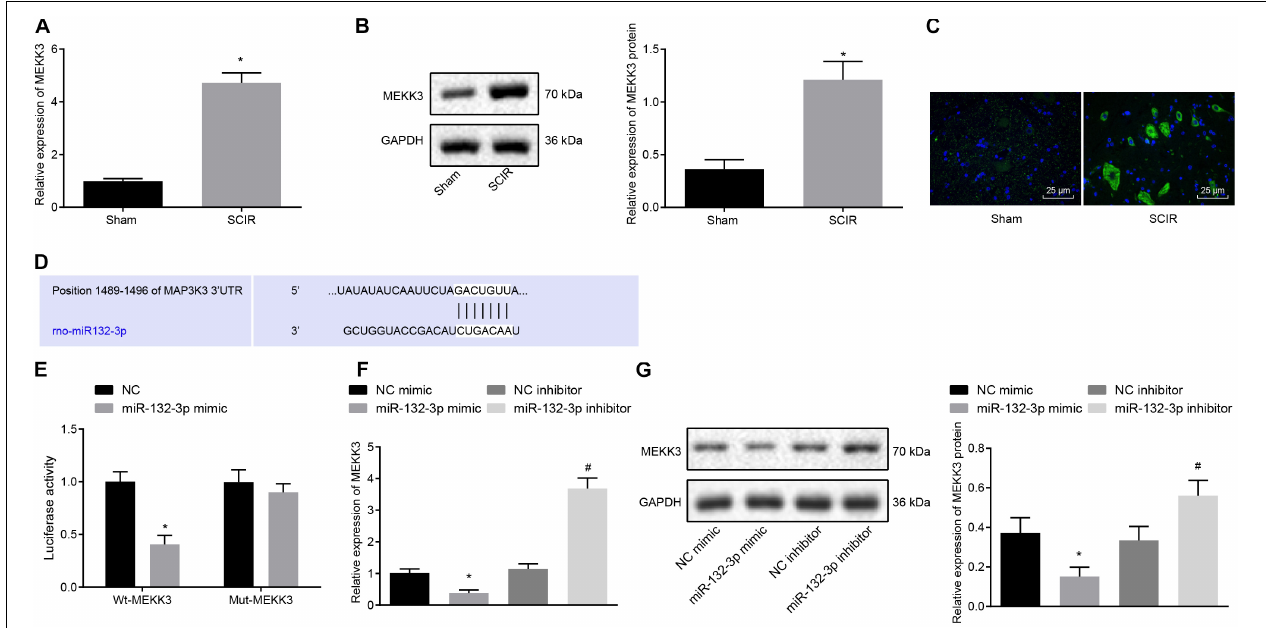
FIGURE 3 | Spinal cord tissues of SCIR injury rats present with high expression of MEKK3 which is a target gene of miR-132-3p. (A) mRNA expression of MEKK3 in spinal cord tissues of sham-operated rats and SCIR injury rats measured by RT-qPCR. (B) Protein expression of MEKK3 in spinal cord tissues of sham-operated rats and SCIR injury rats measured by Western blot analysis; n = 8. (C) Expression of MEKK3 and CD68 in spinal cord tissues of sham-operated rats and SCIR injury rats detected by immunofluorescence staining. (D) Binding sites of miR-132-3p to the 3 (cid:48) UTR of MEKK3 mRNA predicated by a bioinformatics database. (E) Luciferase activity of cells co-transfected with miR-132-3p mimic and MEKK3-WT or MEKK3-MUT detected by dual-luciferase reporter gene assay. (F) mRNA expression of MEKK3 in cells treated with miR-132-3p mimic, miR-132-3p inhibitor, or their NC plasmids detected by RT-qPCR. (G) Protein expression of MEKK3 in cells treated with miR-132-3p mimic, miR-132-3p inhibitor, or their NC plasmids measured by Western blot analysis. ∗ p < 0.05 vs. macrophages transfected with NC mimic. # p < 0.05 vs. macrophages transfected with NC inhibitor. n = 8 for rats following each treatment. Measurement data were expressed as mean ± standard deviation. Differences between two groups were compared by unpaired t -test and those among multiple groups were compared by one-way ANOVA. The experiment was repeated three times